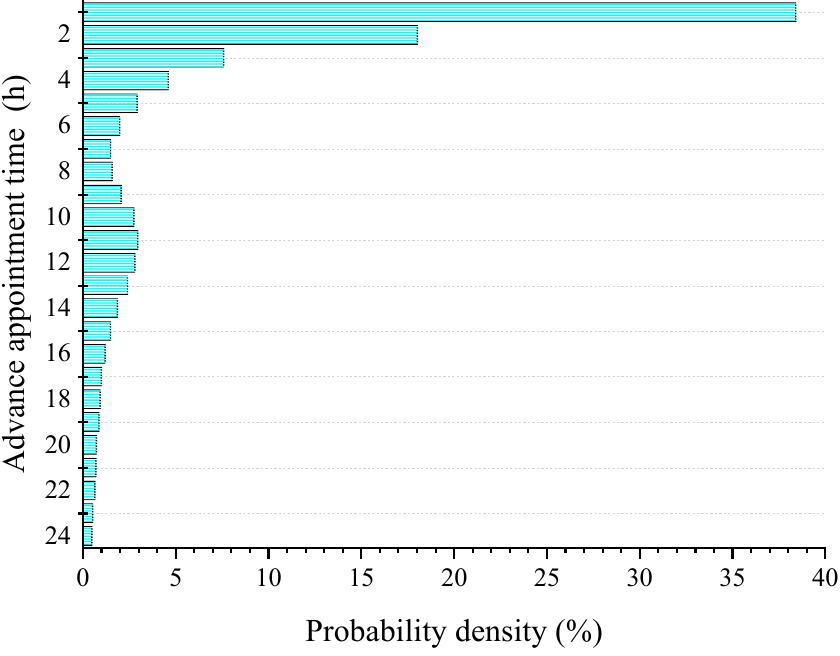
Figure 8. Distribution of intercity ridesplitting advance appointment times.